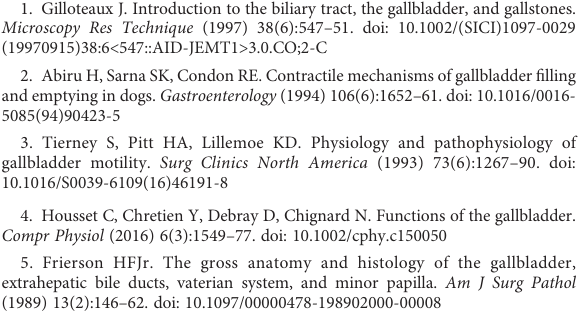
SUPPLEMENTARY FIGURE 3 GSEA analysis wereperformed tocompare GBC cell lines with L-2F7cells, and the pathways on KRAS (A) and estrogen related signals (C, D) were shown. SUPPLEMENTARY FIGURE 4 Myoepithelial markers (S100, KRT4, KRT6, KRT14) were analyzed through RNAseq data of L-2F7 cell and other four cancer cell lines, and the expression levels were shown in heatmap. SUPPLEMENTARY TABLE 1 genomic alternations of L-2F7. The whole exome sequencing analysis of L-2F7, single nucleotide polymorphism, base insertion and deletions in genes were shown in the